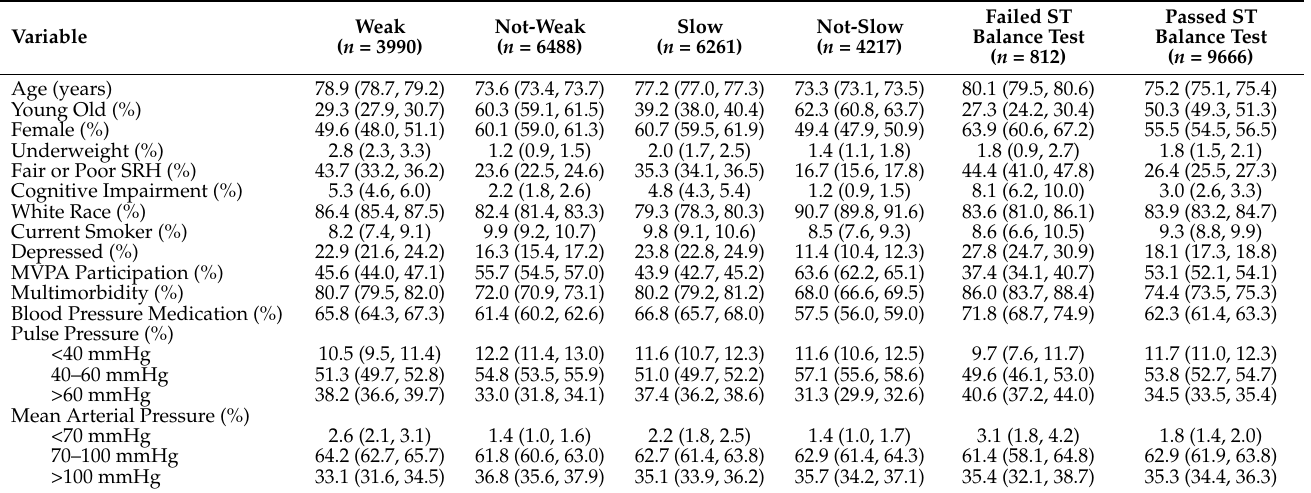
Table 2. Means and 95% Confidence Intervals for the Descriptive Characteristics by Physical Functioning Status.